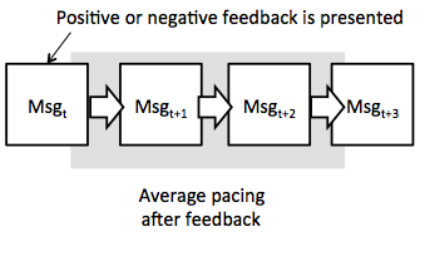
Figure 8. Feedback effect on pacing. Table 8. Descriptive statistics for feedback variables.